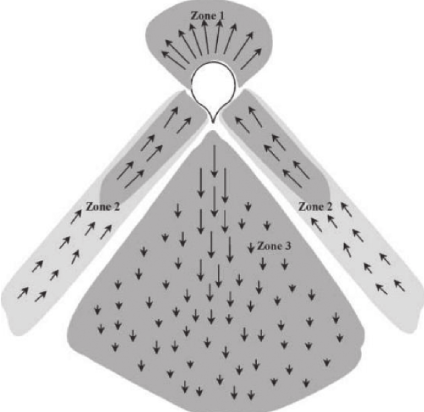
Figure 7: Three distinct flow field zones around a bubble in a viscoelastic fluid